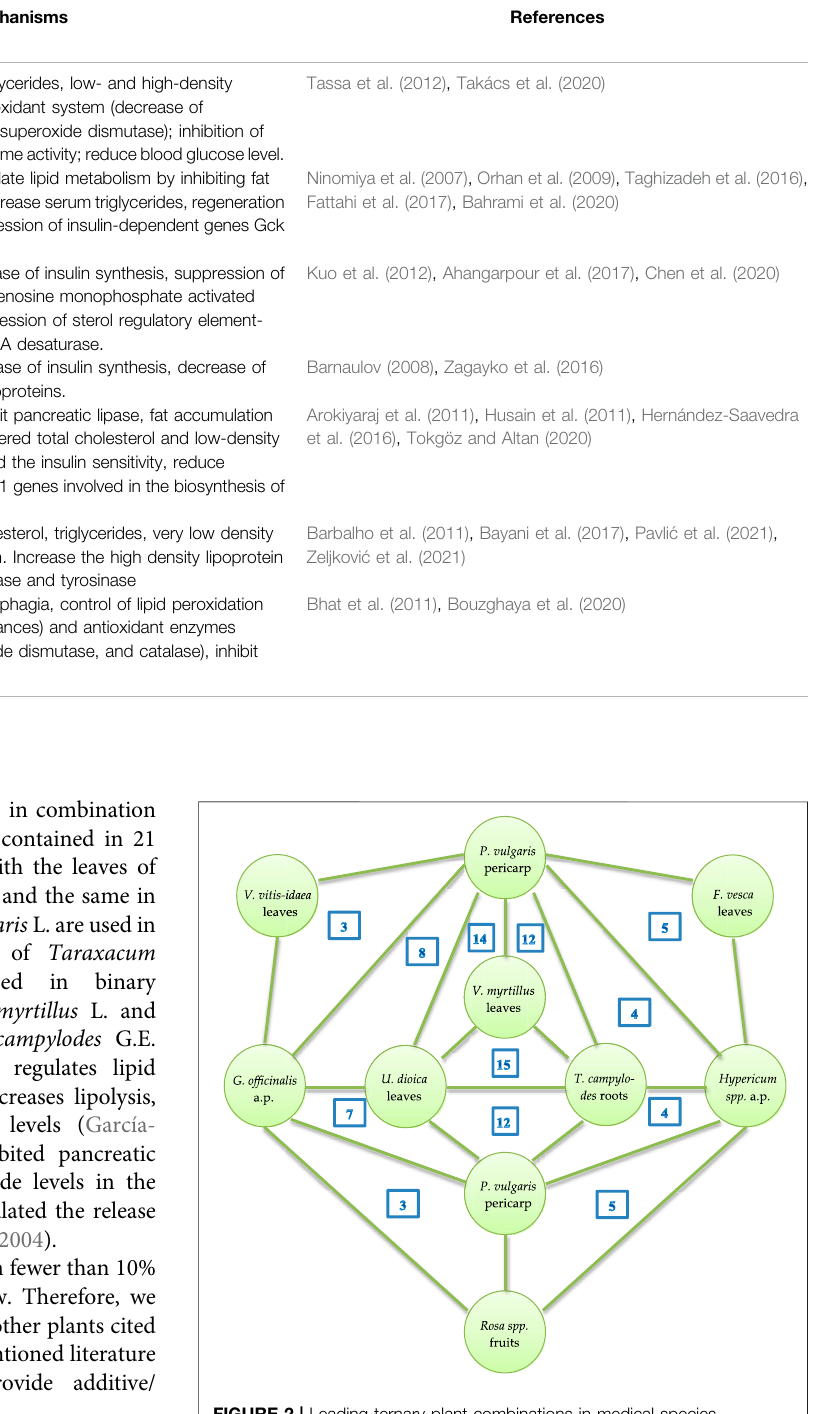
FIGURE 2 | Leading ternary plant combinations in medical species. a.p. — aerialpart;thenumbersinsidetrianglesindicatehowoftentheseternary combinations occur in medical